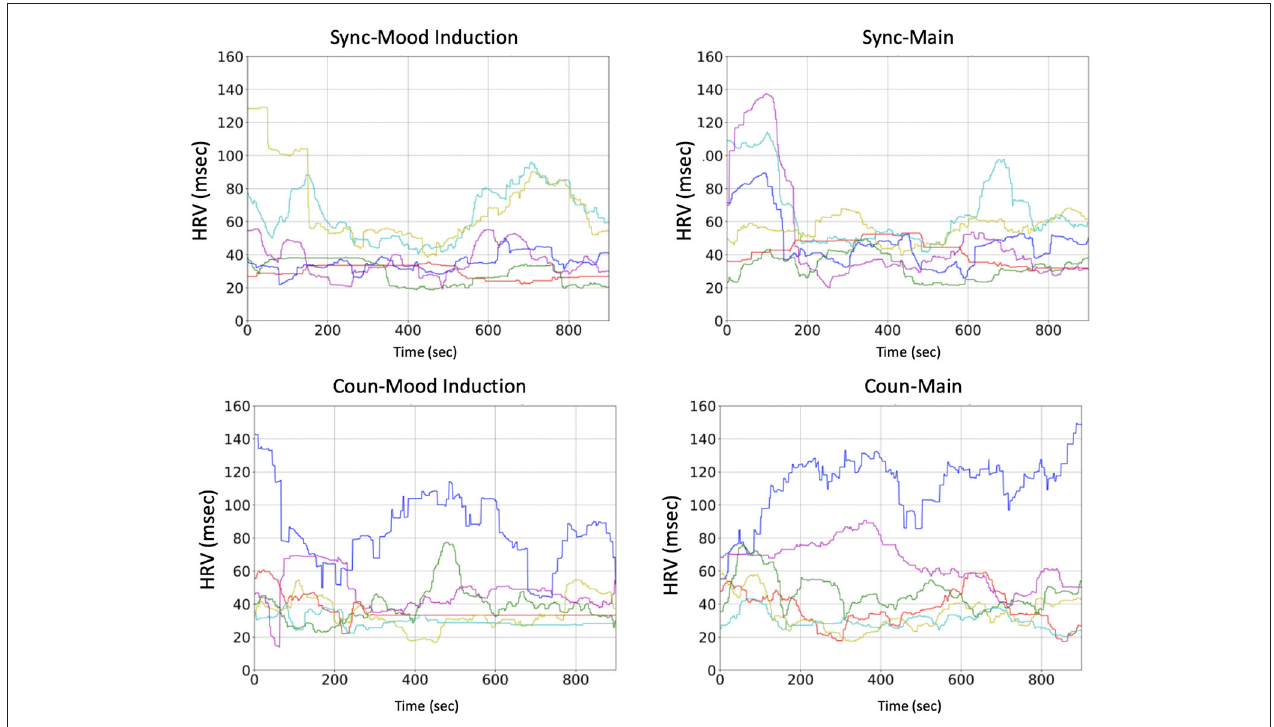
FIGURE 6 | Fluctuations of HRV during the two tasks ( left: mood induction; right: main task). Each line indicates a participant in the two groups ( top: sync; bottom: